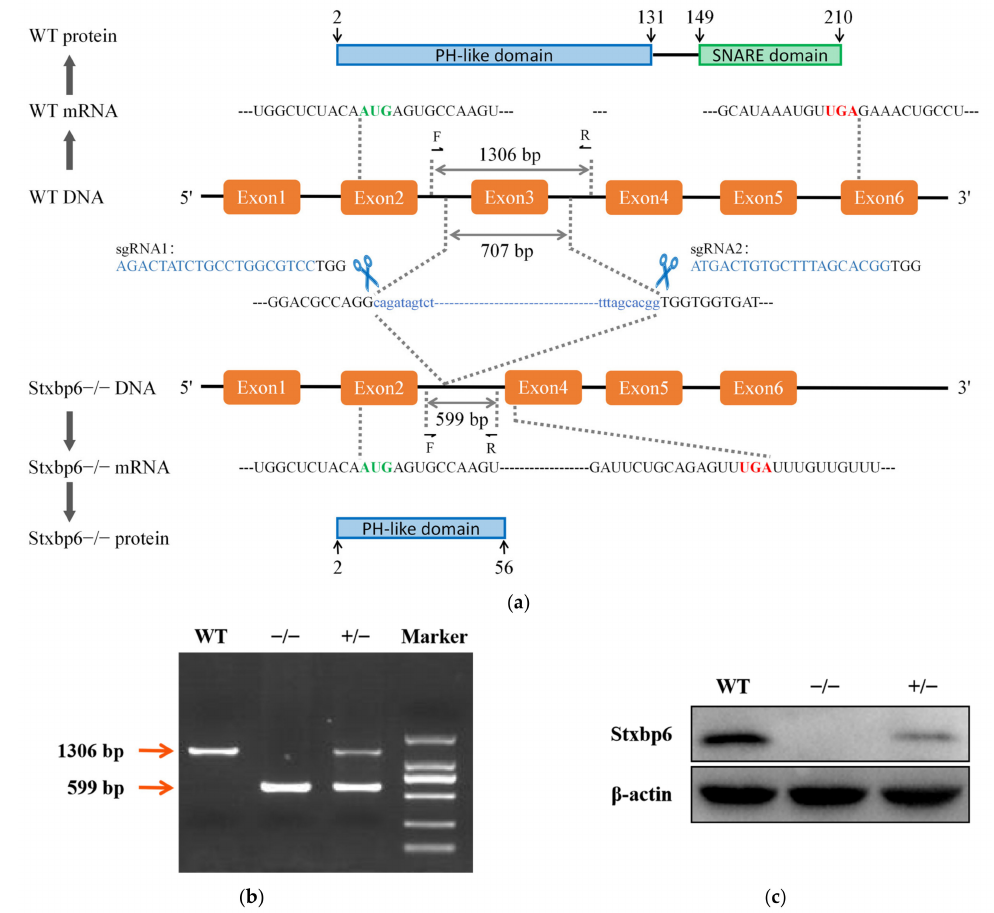
Figure 1. CRISPR/Cas9-mediated generation of Stxbp6-knockout mice. ( a ) Schematic diagram of the CRISPR/Cas9 targeting sites on Stxbp6; ( b ) PCR genotyping of Stxbp6 wildtype (WT) (1306 bp), heterozygous (1306 bp and 599 bp), and homozygous (599 bp) mice. ( c ) Stxbp6 protein expression analysis by Western blot. β -actin was used as a loading